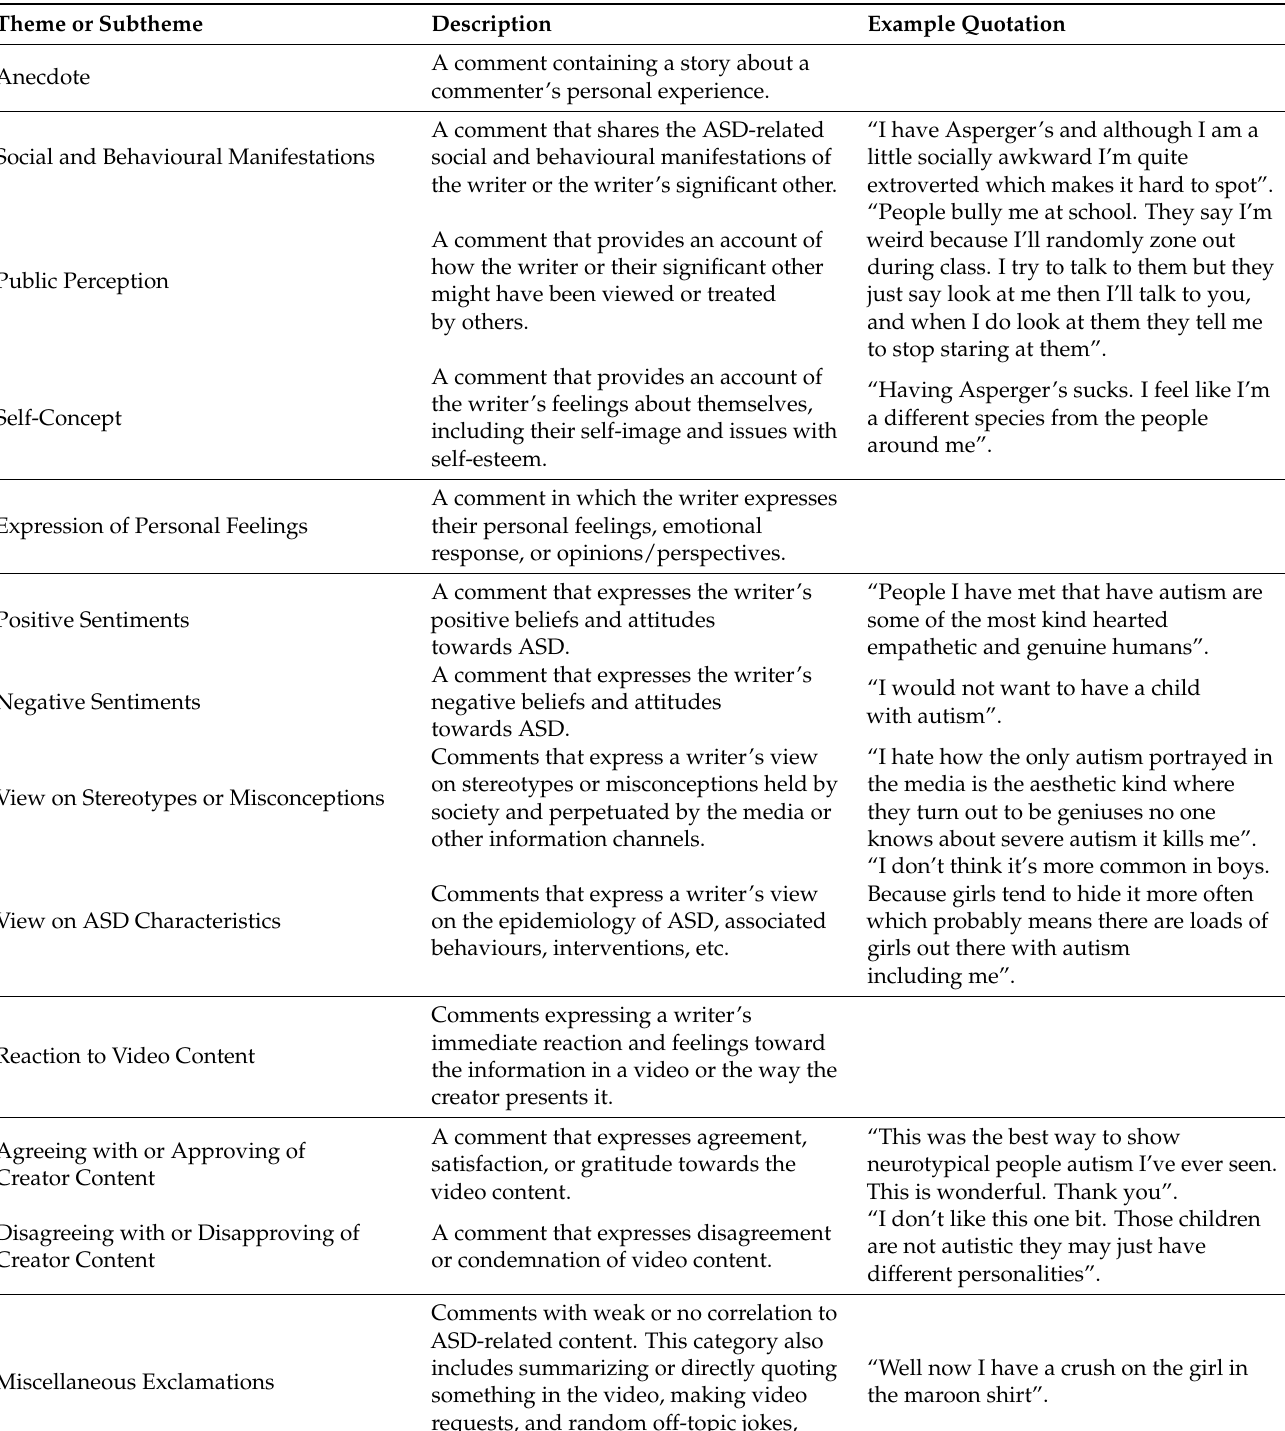
Table 3. Themes and subthemes in YouTube comments with example